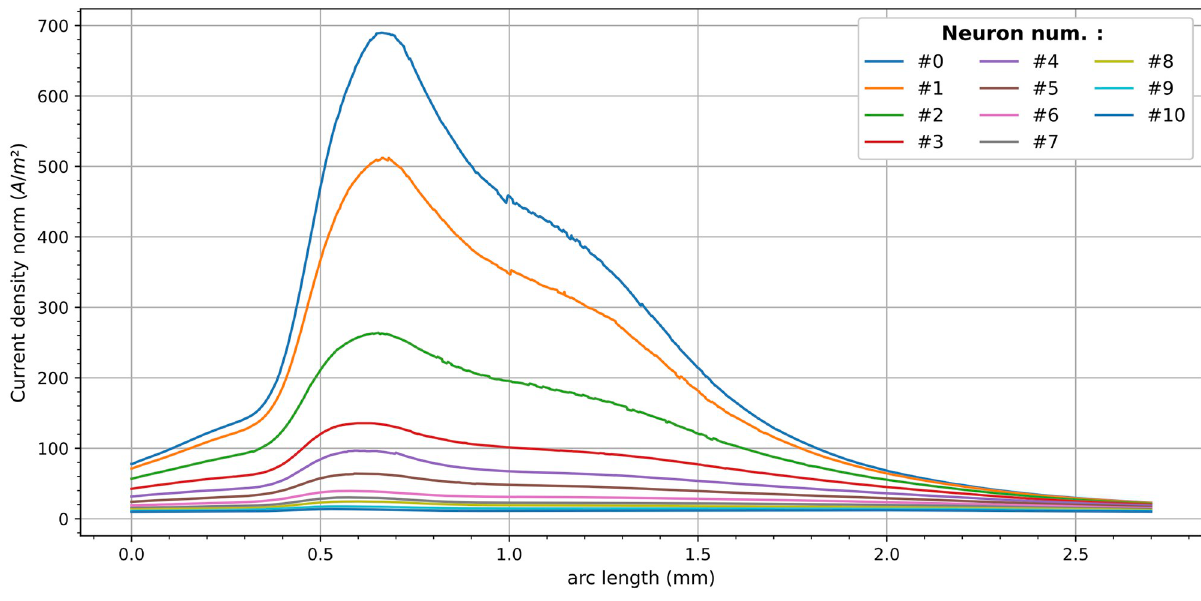
Fig 8. Current densities at the first 11 VN when E s supply a current of − 1 mA.